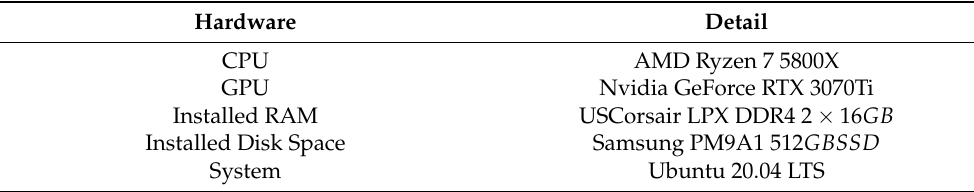
Table 2. Hardware Table 2. Hardware information.